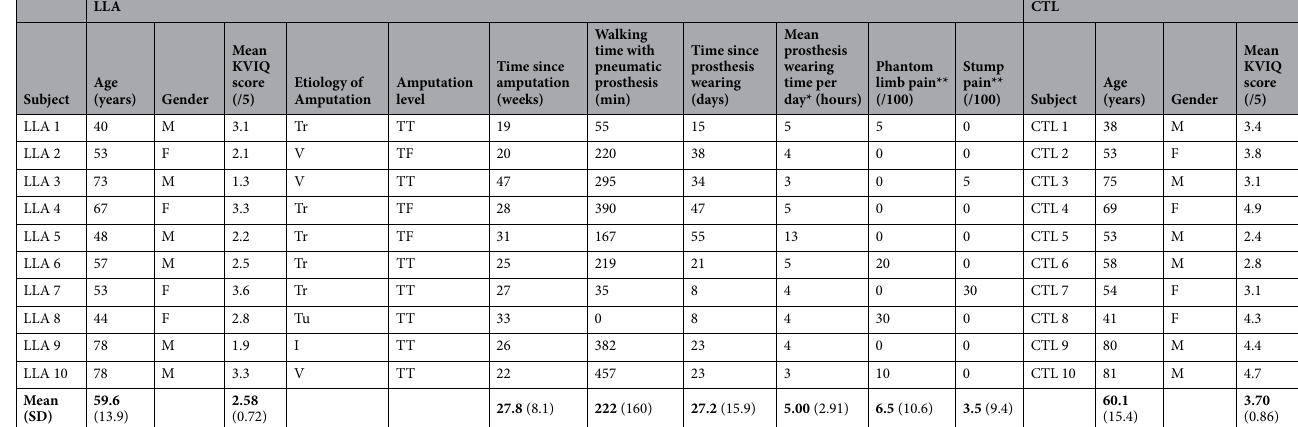
Table 1. Characteristics of the participants in the LLA and CTL groups. M, Male; F, Female; I, Infectious; Tr, Traumatic; Tu, Tumoral; V, Vascular; TT, Transtibial; TF, Transfemoral. *During the week before testing, **At the beginning of